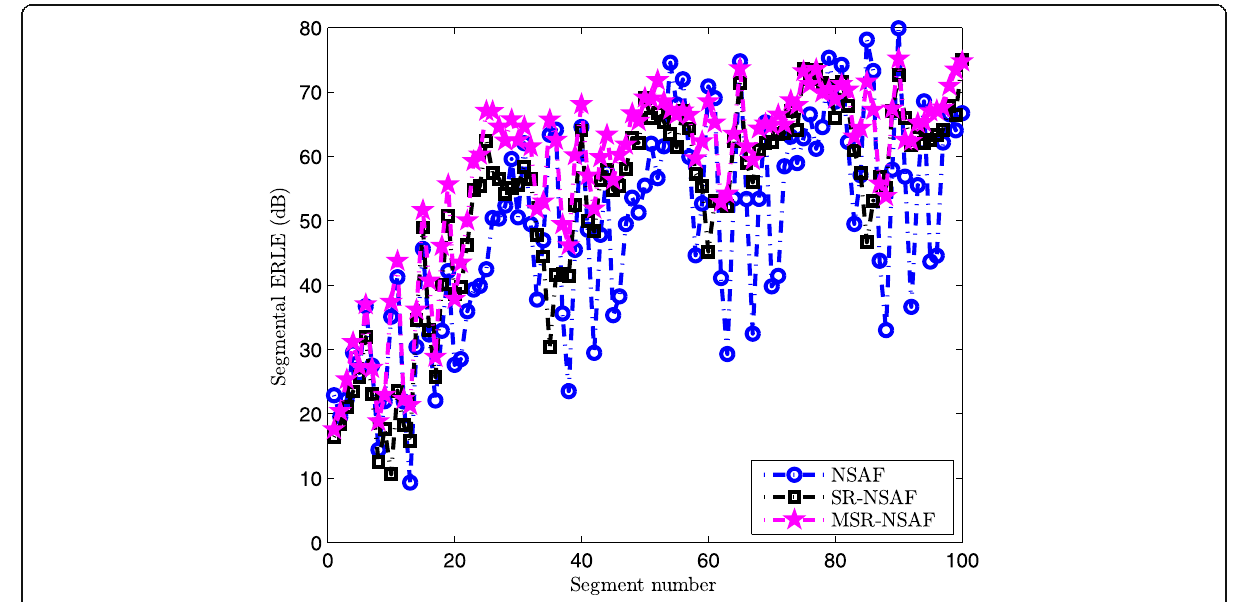
Fig. 16 Segmental ERLE curves of NSAF, SR-NSAF and MSR-NSAF